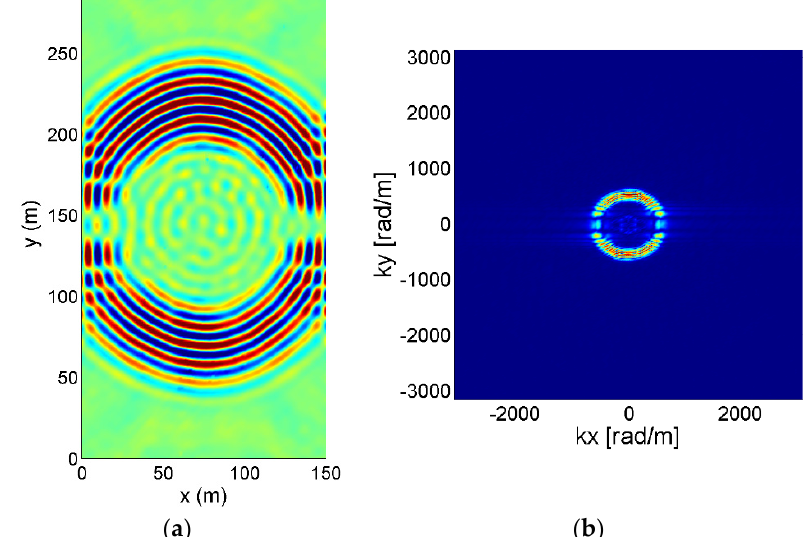
Figure 2. Full wavefield image captured at time moment t 1 : ( a ) in the space-space domain; ( b ) in the wavenumber-wavenumber domain.